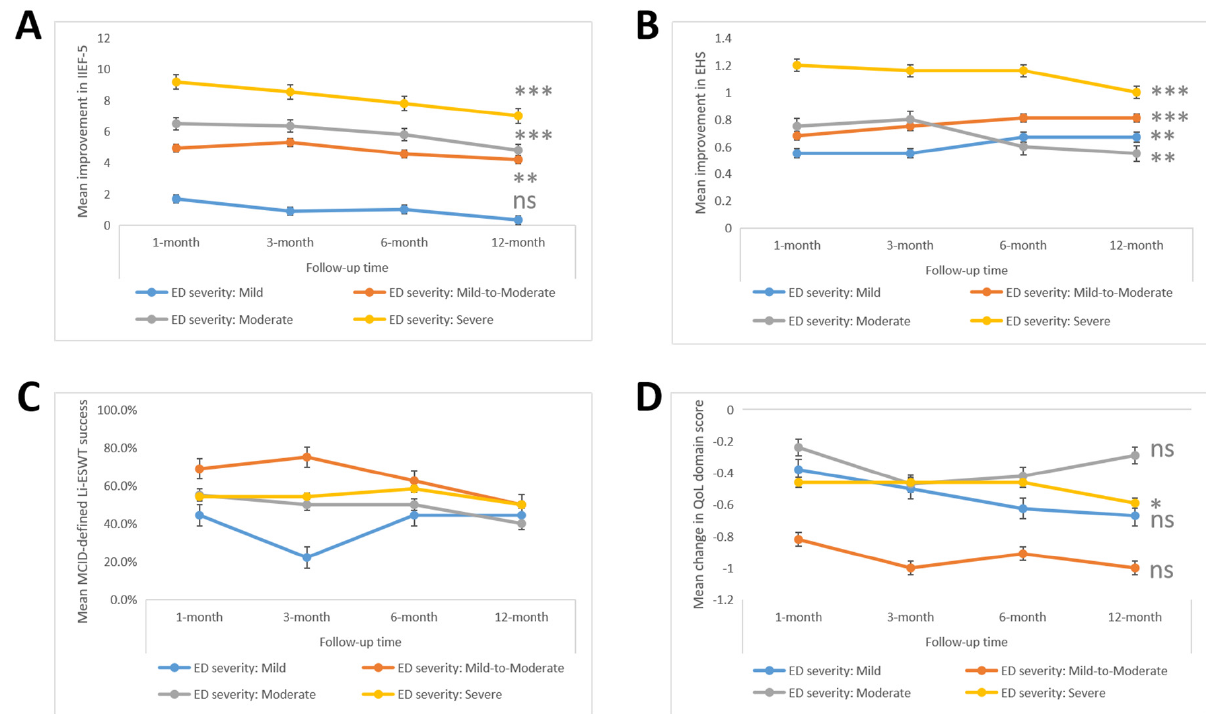
Figure 1. The therapeutic efficacy of Li-ESWT in patients stratified by ED severity. Line graphs showing the ( A ) mean improvement in IIEF-5, ( B ) mean improvement in EHS, ( C ) mean MCID-defined Li-ESWT success, and ( D ) mean change in QoL domain score in patients with mild, mild-to-moderate, moderate, or severe ED, at indicated time-points. ns, non-significant; * p < 0.05, ** p < 0.01, *** p < 0.001; Li-ESWT, low-intensity extracorporeal shockwave therapy; ED, erectile dysfunction; IIEF-5, five-item International Index for Erectile Function; EHS, Erection Hardness Score; MCID, minimal clinically important difference; QoL, quality of life.